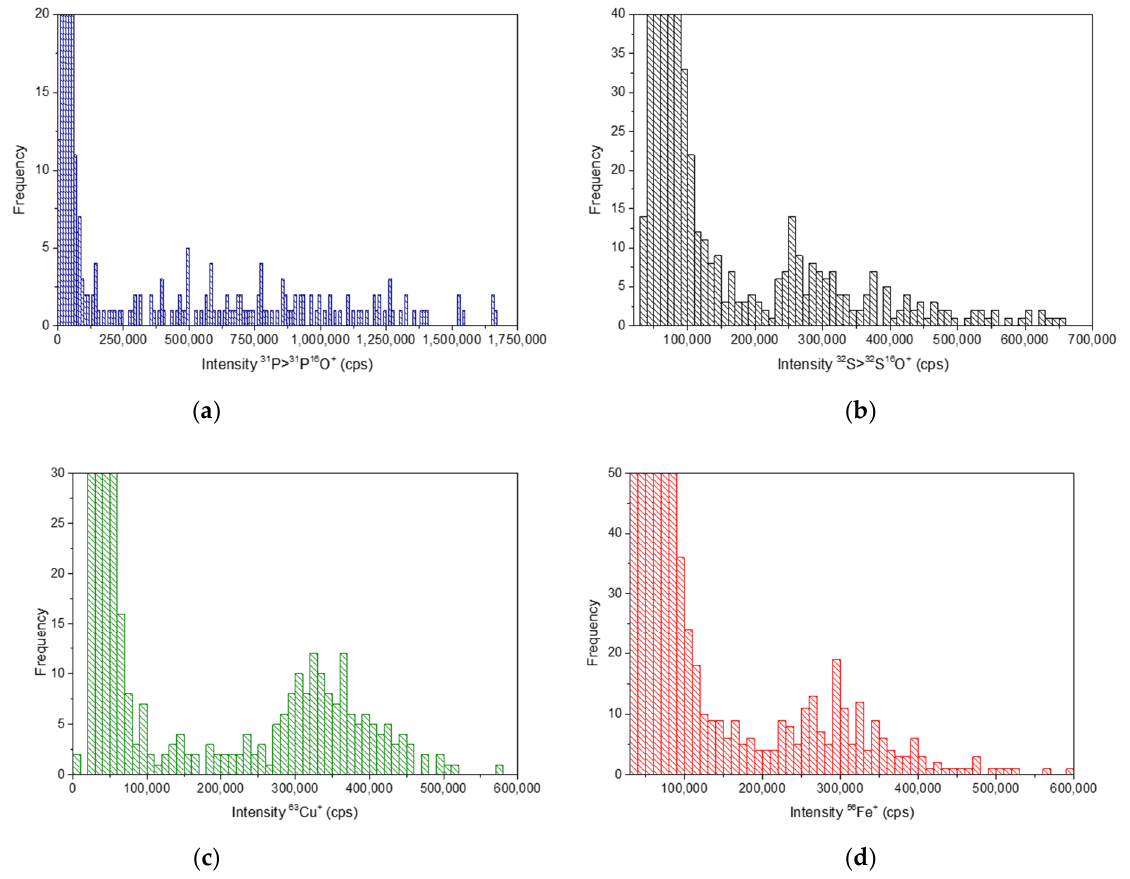
Figure 3. Histograms that show the signal distribution of spleen cells monitoring ( a ) 31P + (as 31P16O + ), ( b ) 32S + (as 32S16O + ), ( c ) 63Cu + and ( d ) 56Fe + . Phosphorus is present in the phospholipids of the cell membrane, in the nucleic acids, as phosphate, and in a huge variety of biomolecules. Sulphur is mainly present in methi- onine and cysteine, which are two of the amino acids that constitute cell proteins. Iron and copper are essential elements whose metabolisms are closely related. Both are required as